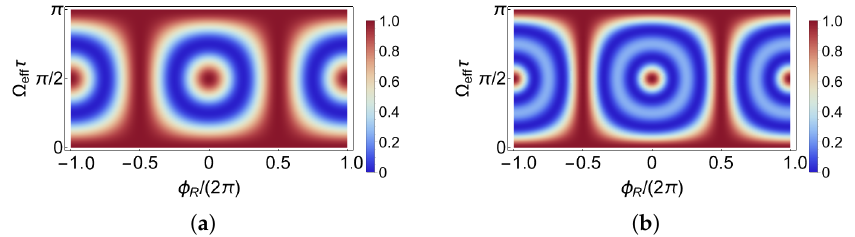
Figure 3. Ramsey fringes observed on | F ,0 (cid:105) state setting parameters as pulse area Ω eff τ and in- terferometer phase φ R in the ( a ) F = 1 system and in the ( b ) F = 2 system. Colorbars indicate the probability.